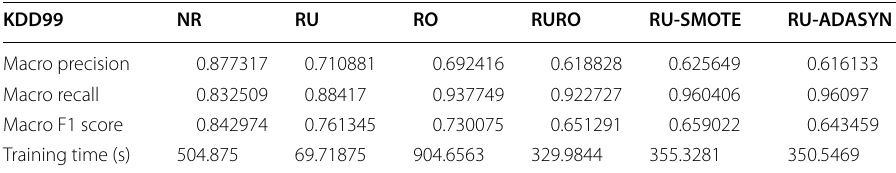
Table 12 ANN classification results for KDD99 on local machine for various resampling methods